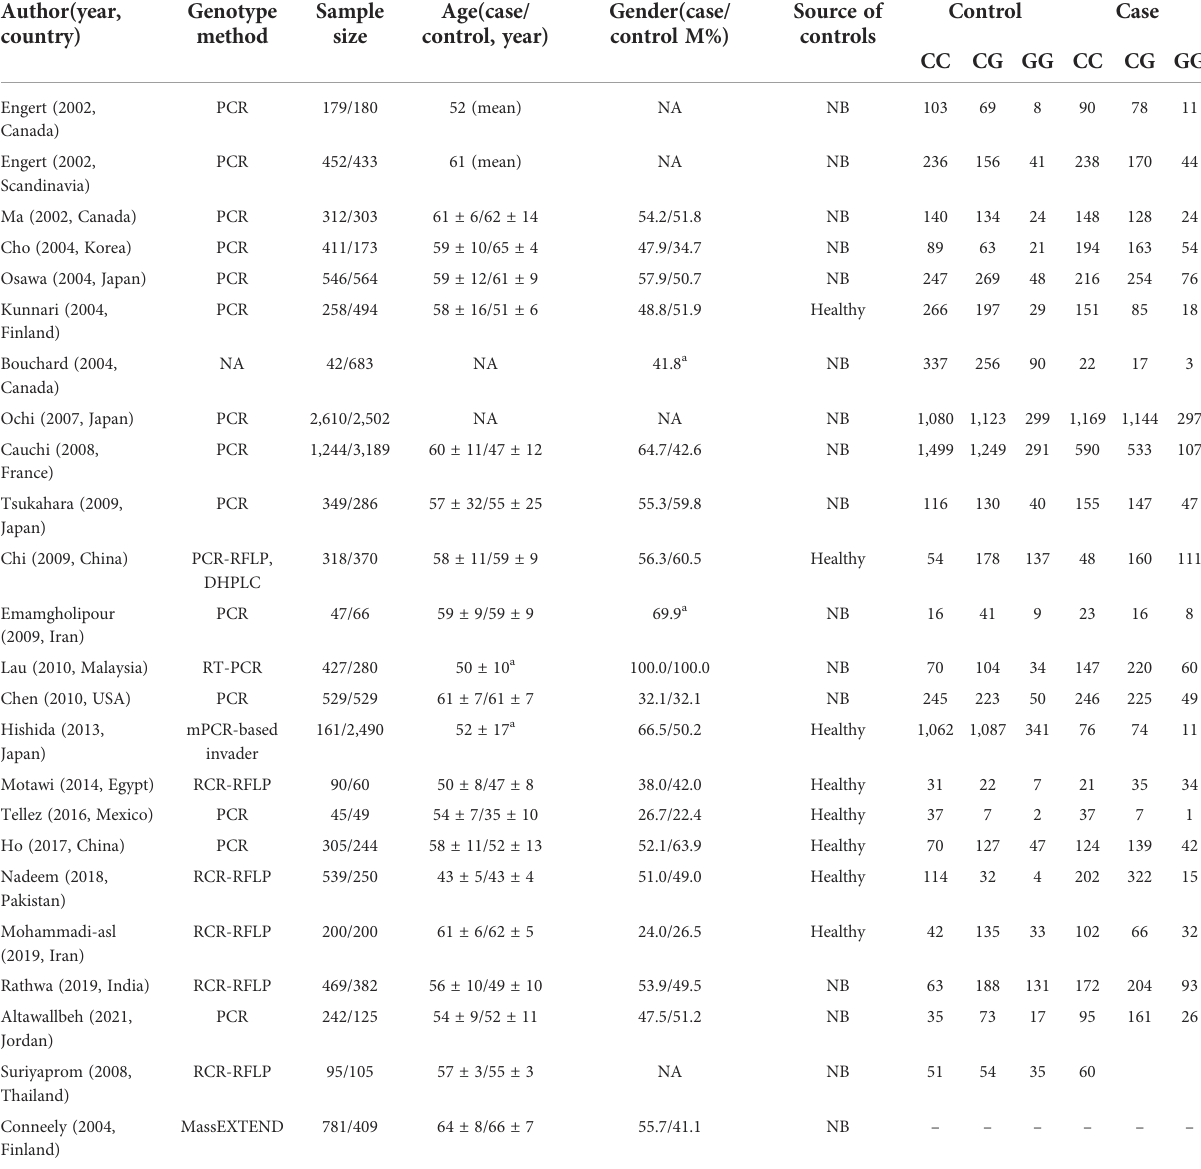
TABLE 1 Characteristics of the investigated studies on the association between the resistin (RETN) -420C/G gene polymorphism and type 2 diabetes mellitus (T2DM) susceptibility.